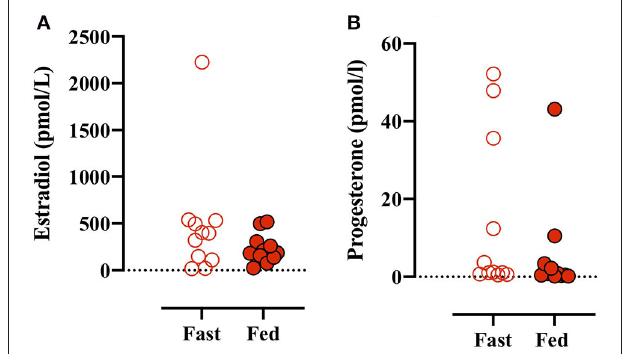
FIGURE 2 | (A) Plasma estradiol concentrations measured before the first GXT on the Fast (open red circles) and Fed (closed red circles) days. (B) Plasma progesterone concentrations before the initial GXT on the Fast and Fed days. Paired t -test (estradiol): p = 0.238 and (progesterone): p =